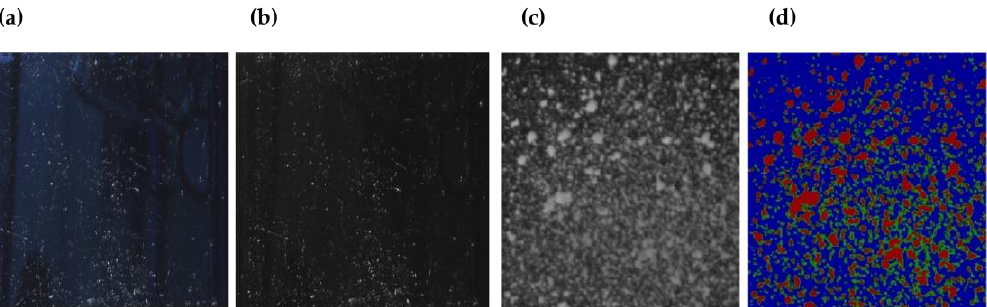
Figure 8. ( a ) LiDAR steady state: blue value = 53–58, ( b ) state of blue value = 0, ( c ) excluding reflected light, ( d ) RGB conversion.